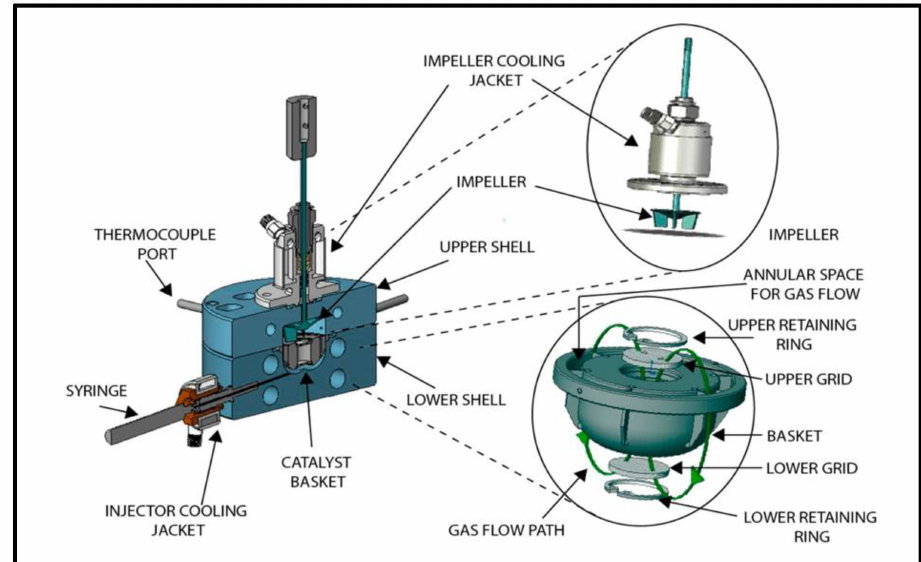
Figure 8. Schematic of the various components (body of the reactor unit, impeller and catalyst basket) of the CREC Riser Simulator [22,23].